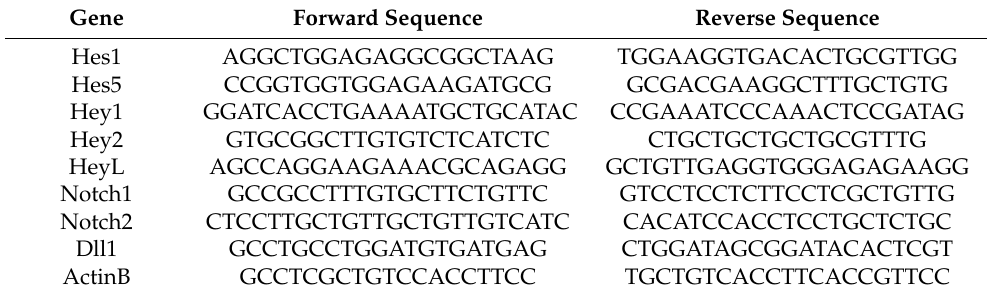
Table 1. Primers of real-time